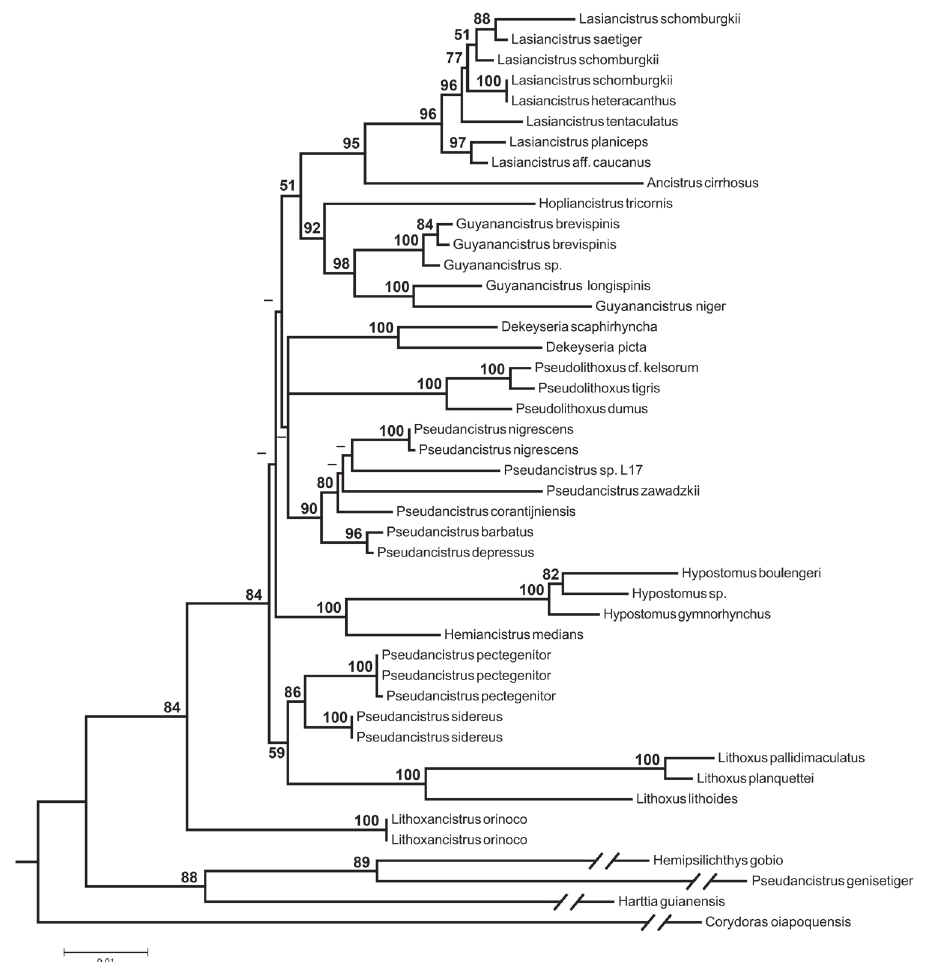
Figure 2. Maximum-likelihood tree based on nuclear gene sequence F-reticulon 4 (-lnL = 11470.59). Numbers next to nodes are bootstrap values based on 1,000 pseudoreplicates. Values below 50% are not